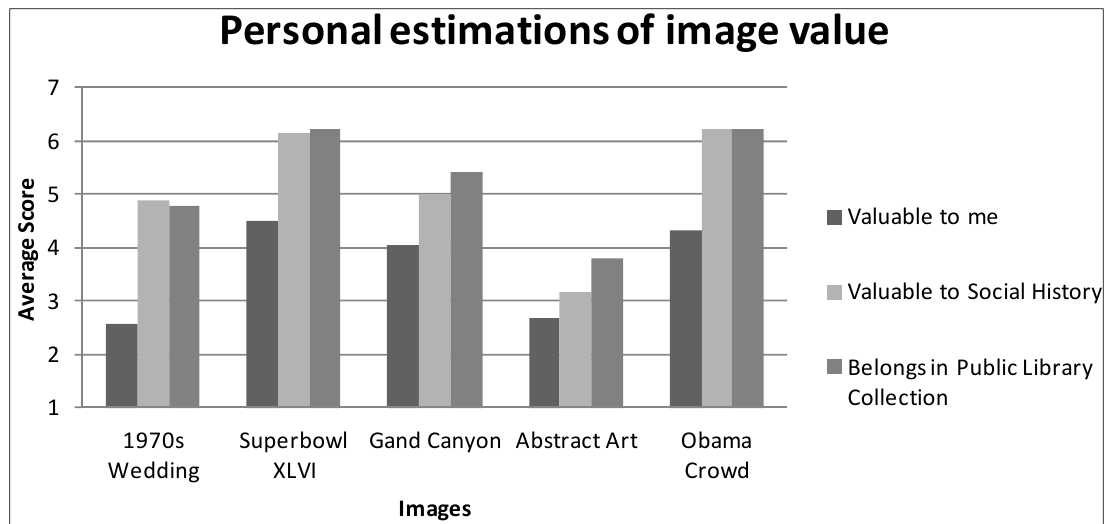
Figure 5. Comparison of averages for value and inclusion in public library collections for all images from all respondents ( N = 60).